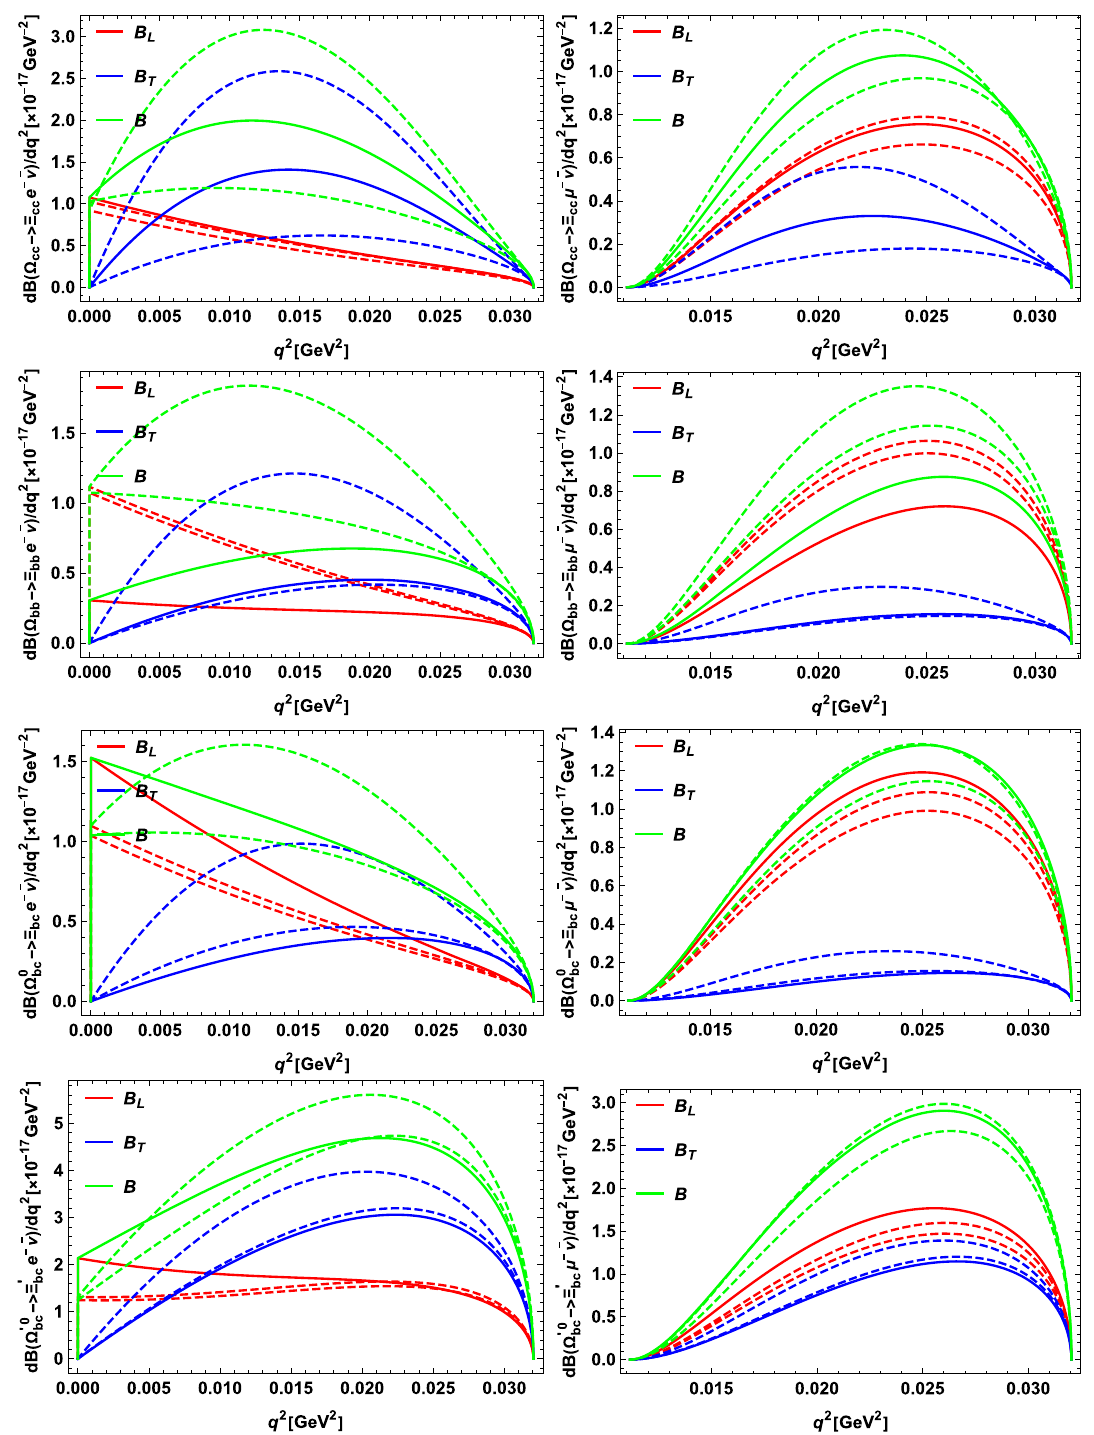
Fig. 3 The differential decay width dB/d q 2 of spin-1/2 to spin-1/2 doubly heavy baryon decay processes. The B L and B T represent the contribution of longitudinal polarisation and transverse polarisation in branching fractions in Eq.